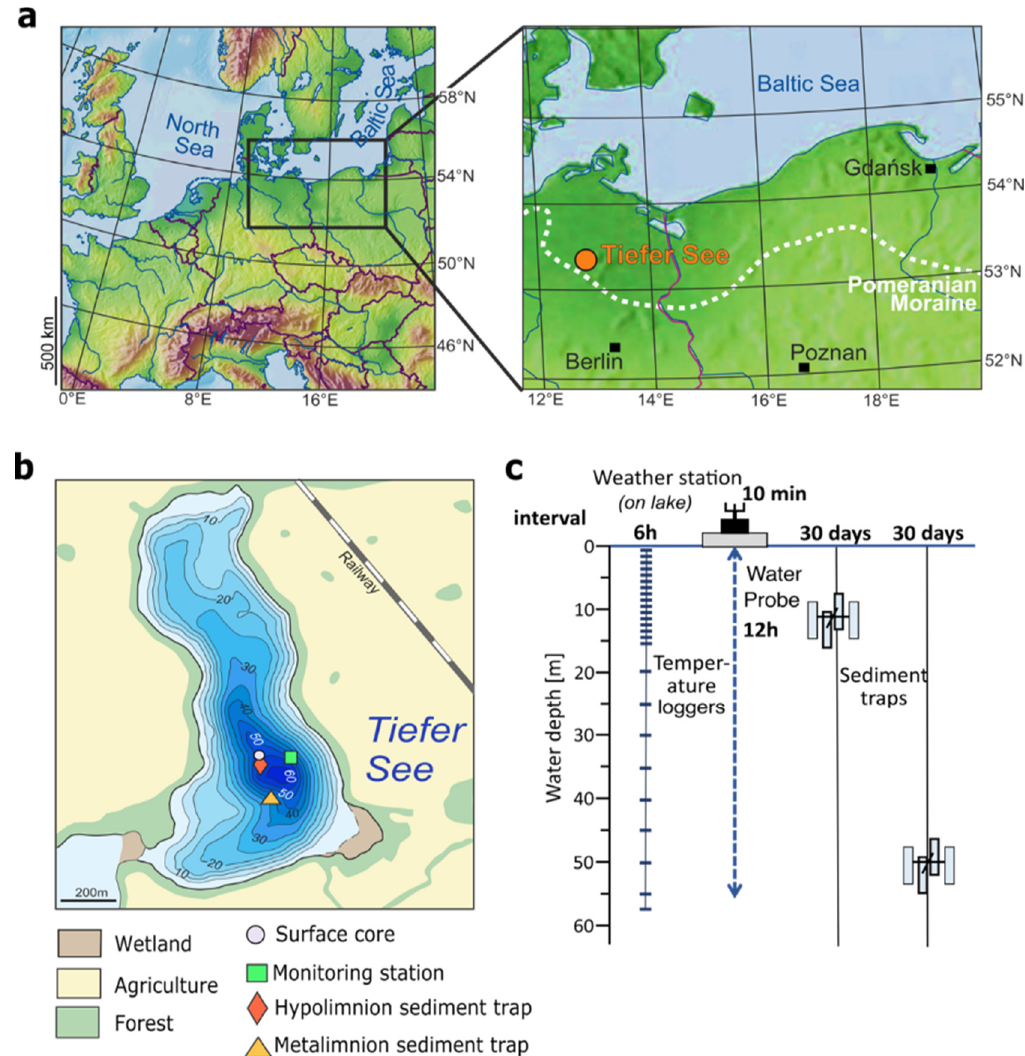
Figure 1. Location of the study site and information on the monitoring setup: ( a ) The location of Lake Tiefer See near Klocksin (TSK, northeastern Germany); ( b ) A bathymetric map of Lake Tiefer See showing the sites of climate monitoring stations, water sampling, sediment traps, and surface core extraction, and ( c ) A scheme of lake monitoring setup showing depths of water column, temperature loggers, and depths at which the sediment traps are anchored.